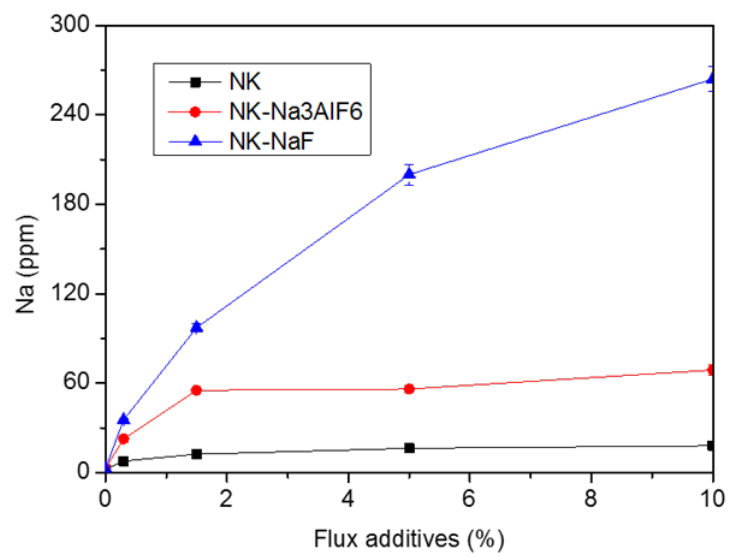
Figure 1. Effect of different sodium-containing fluxes on the residual content of sodium in Al–10Mg 121 alloy. 122